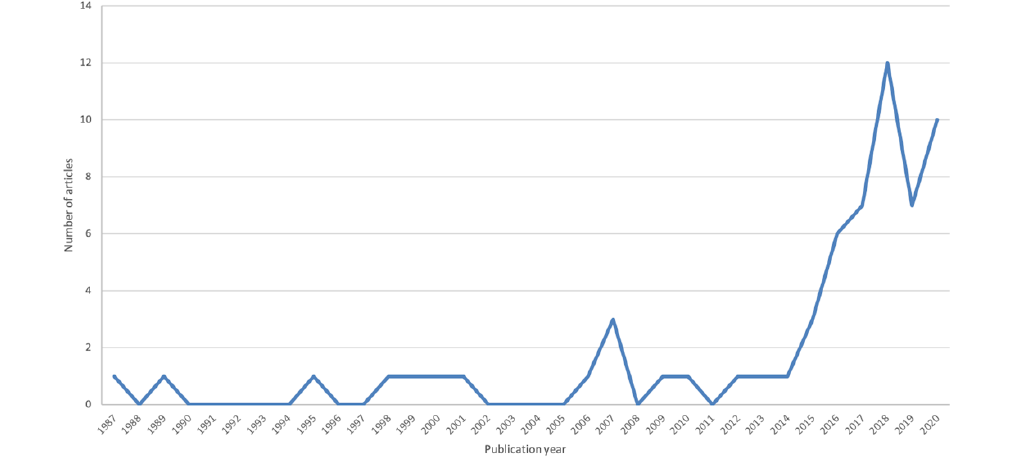
Figure 1. PRISMA flow diagram.